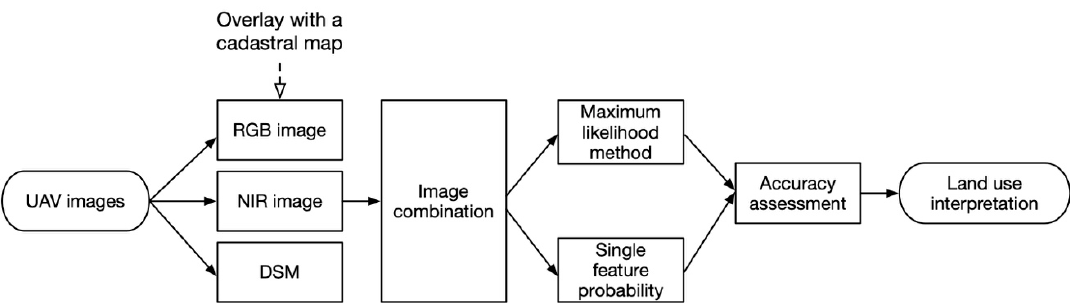
Figure 2. Research flowchart.